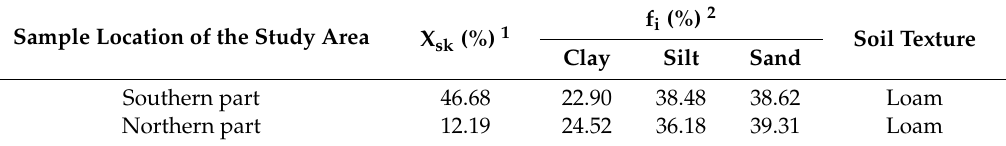
Table 2. Results of the particle analysis.